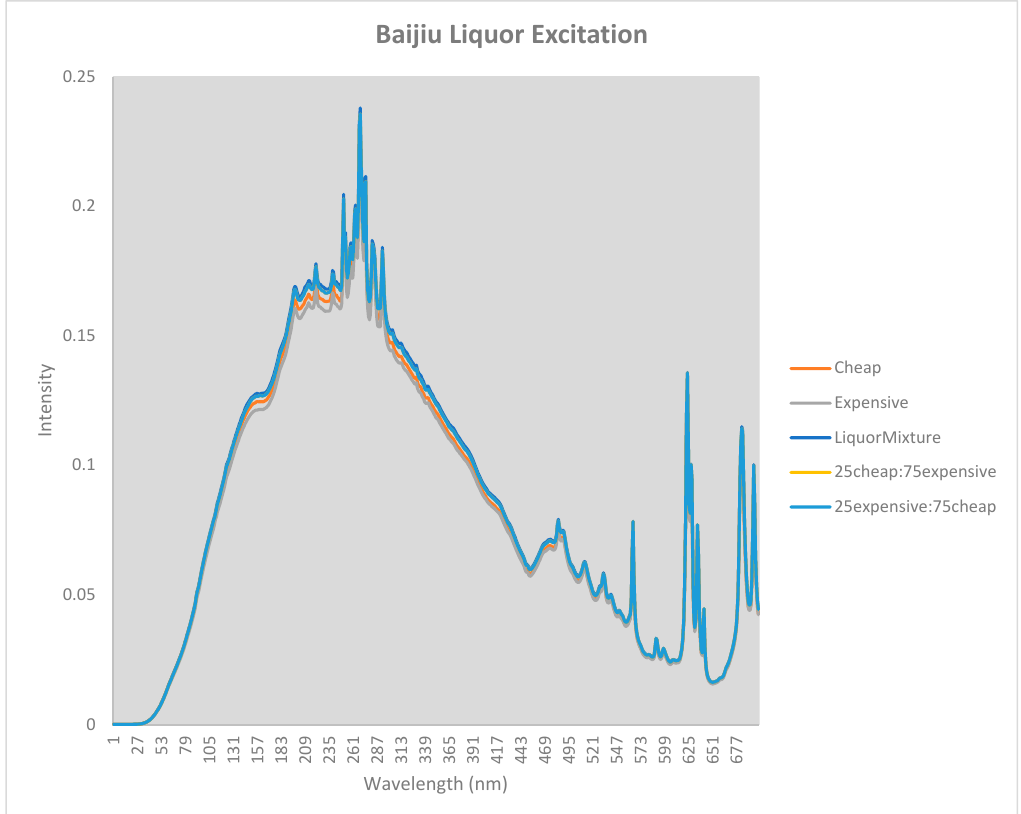
Figure 4. Baijiu spirit excitation of different ratios of inexpensive to expensive baijiu spirits. Visual differences can be noted in the emission spectra for both mixtures, which can be seen in Figure 5 for Moutai and Figure 6 for baijiu spirits.